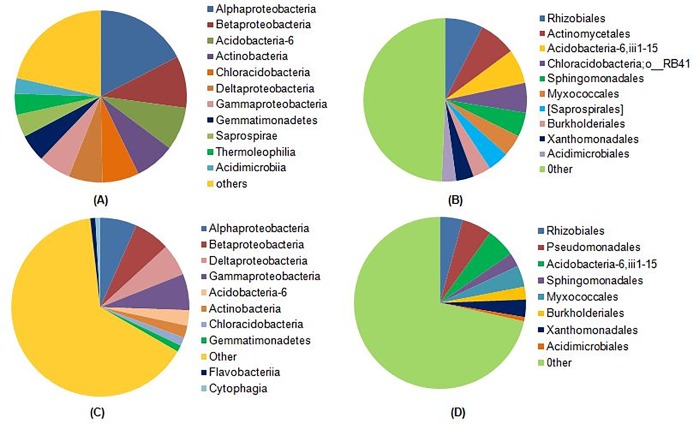
Comparative representation of bacterial taxa in Gangotri and Kandakhal soil.Where, (A) and (B) represents the relative percentage of bacterial class and order in Gangotri soil and (C) (D) represent dominant classes and order in Kandakhal soil.